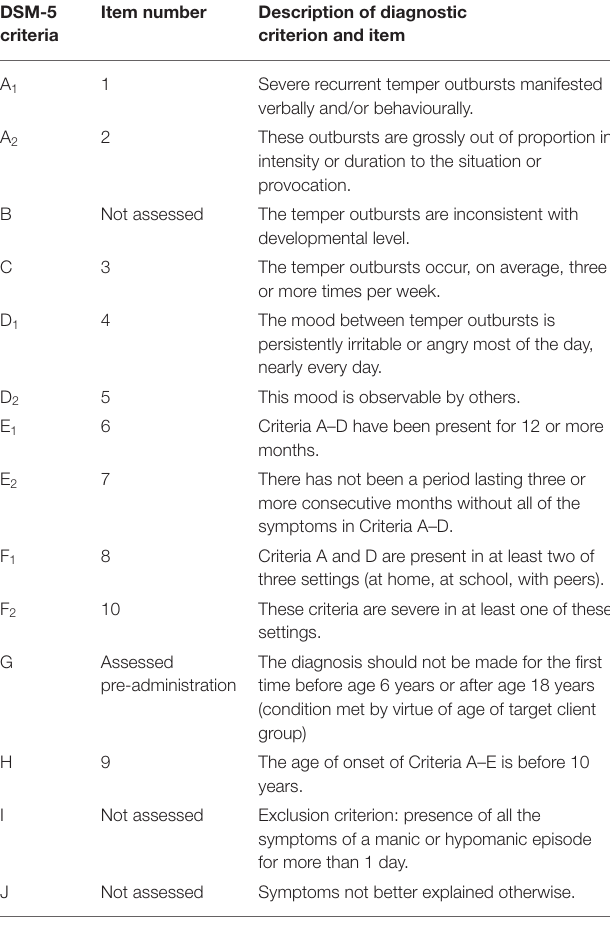
TABLE 1 | DSM-5 diagnostic criteria for DMDD and DMDD Questionnaire items. DSM-5